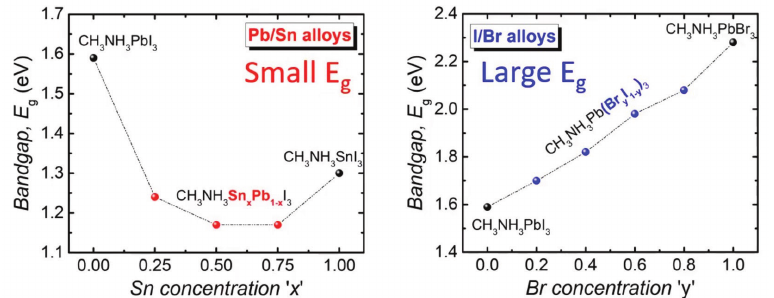
Figure 1. Variation of the forbidden gap in perovskites versus the chemical composition. There are two families of perovskites, with low ( left ) and high ( right ) gaps, which can be utilized to construct perovskite-perovskite tandem cells or to optimize the plasmonic effect. Reproduced with permission [37].